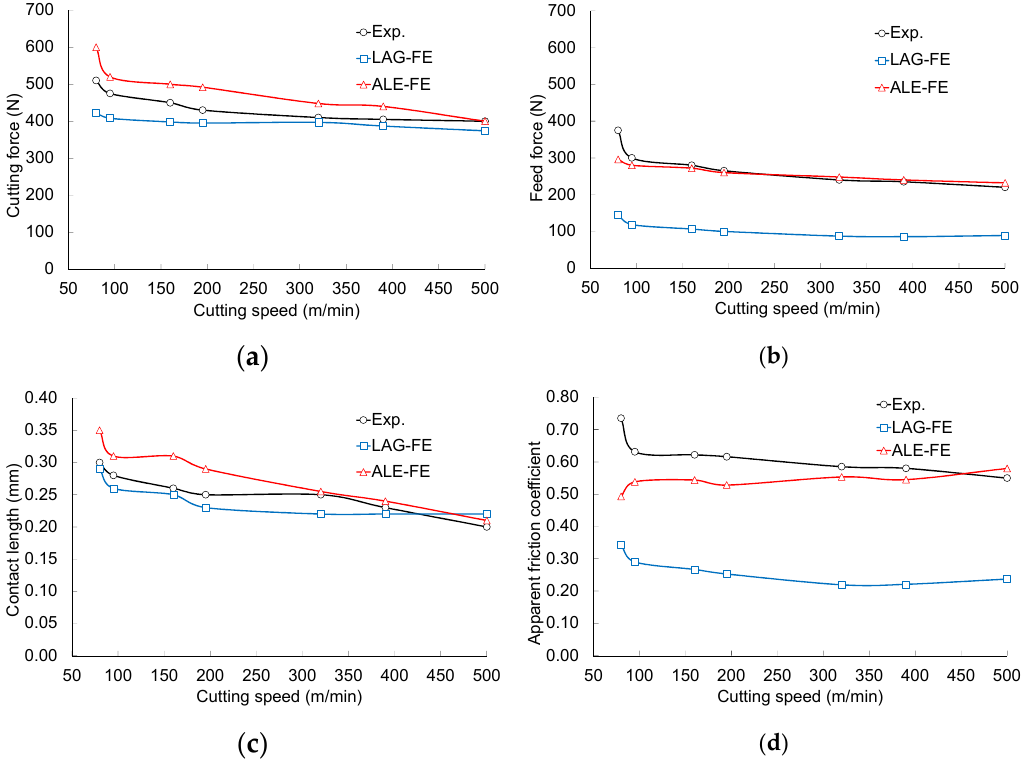
Figure 7. Experimental vs. numerical modelling (ALE ‐ FE and LAG ‐ FE) of ( a ) cutting force, ( b ) feed force; ( c ) contact length, and ( d ) apparent friction coefficient. Table 5. Comparison between experimental data and LAG ‐ FE results.